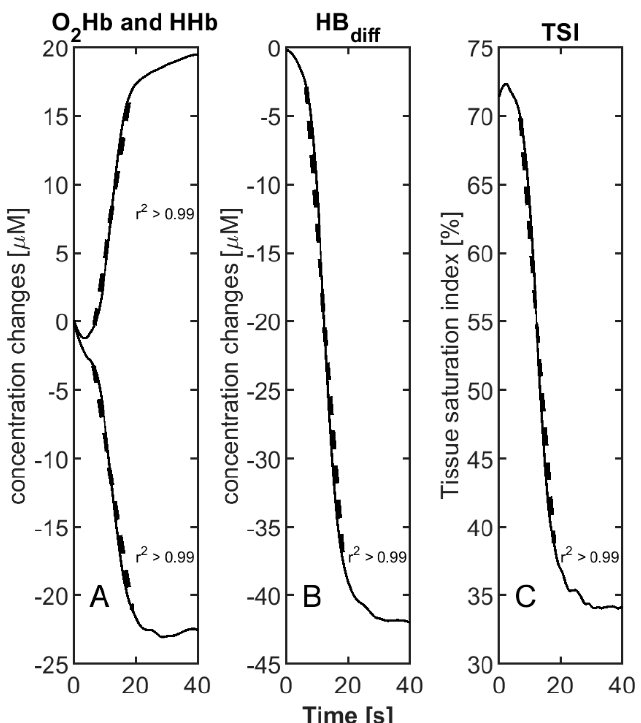
Figure 2. Exemplar data showing the five different approaches to estimate muscle oxygen consump- tion out of the initial slope using simple linear regression modelling (dashed lines, r 2 > 0.99). (1) Slope of oxygenated hemoglobin ( A : negative line). (2) Slope of deoxygenated hemoglobin (A: positive line). (3) Mean out of slope from oxygenated and deoxygenated hemoglobin ( A ). (4) Estimation of the slope out of the subtraction of oxygenated and deoxygenated hemoglobin ( B ). (5) Slope of the tissue saturation index ( C ). mVO 2 was normalized using the respective delta value. The delta value was defined as the difference between the value at the onset of the contraction and the minimum (TSI, Hbdiff, HHb) or maximum (O 2 Hb) value that occurred during the contraction. In addition, we analyzed the tHb level to detect possible shifts in the blood volume during the analysis window. The analysis window represents the time between the start and end of the linear slope. This time window was split in two sections of equal length (t1, t2). For both sections, a mean value was